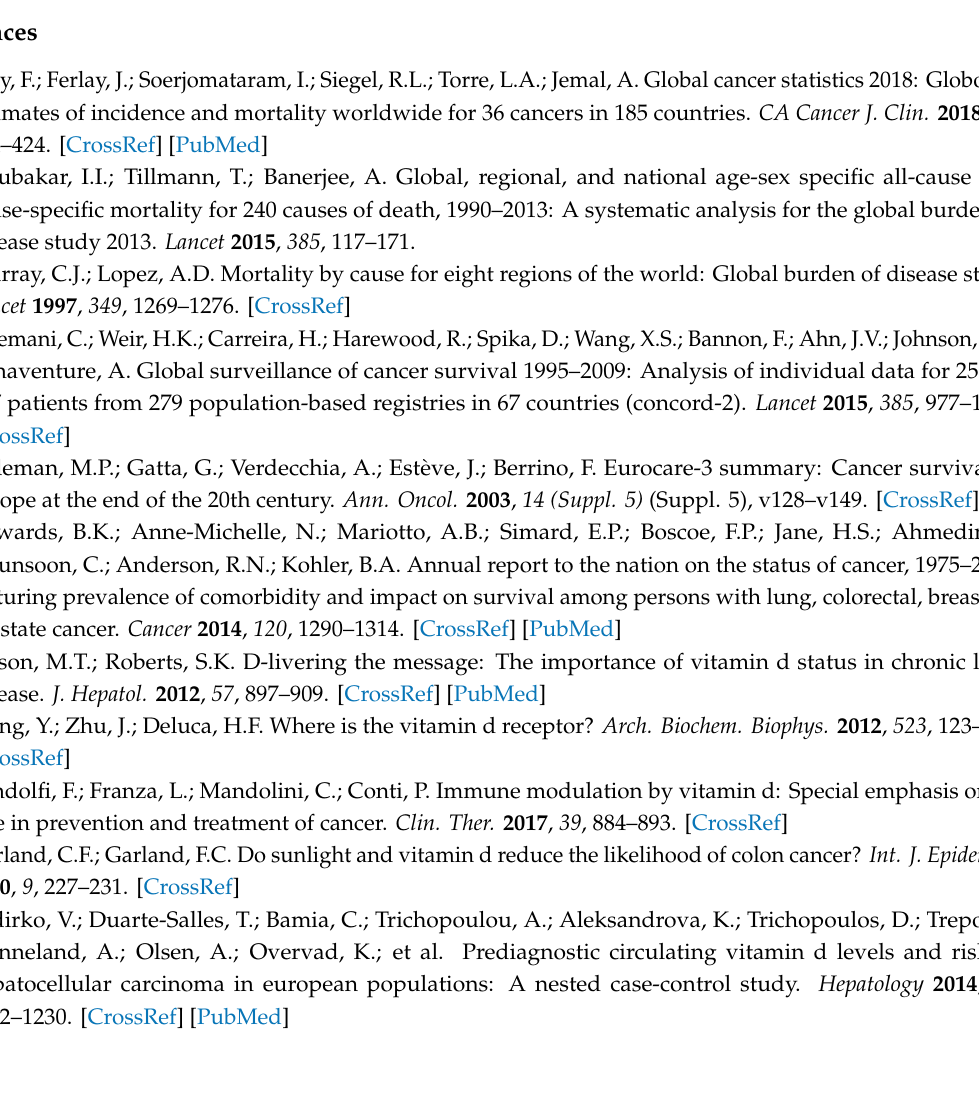
Figure S1: Sensitivity analysis with respect to vitamin D concentration and cancer incidence; Figure S2: Sensitivity analysis with respect to vitamin D concentration and cancer mortality; Table S1 Quality assessment of studies investigating 25(OH)D and cancer risk, according to the Newcastle-Ottawa Scale; Table S2. Quality assessment of studies investigating 25(OH)D and cancer mortality, according to the Newcastle-Ottawa Scale; Table S3: Subgroup and meta-regression analyses for cancer incidence; Table S4: Subgroup and meta-regression analyses for cancer